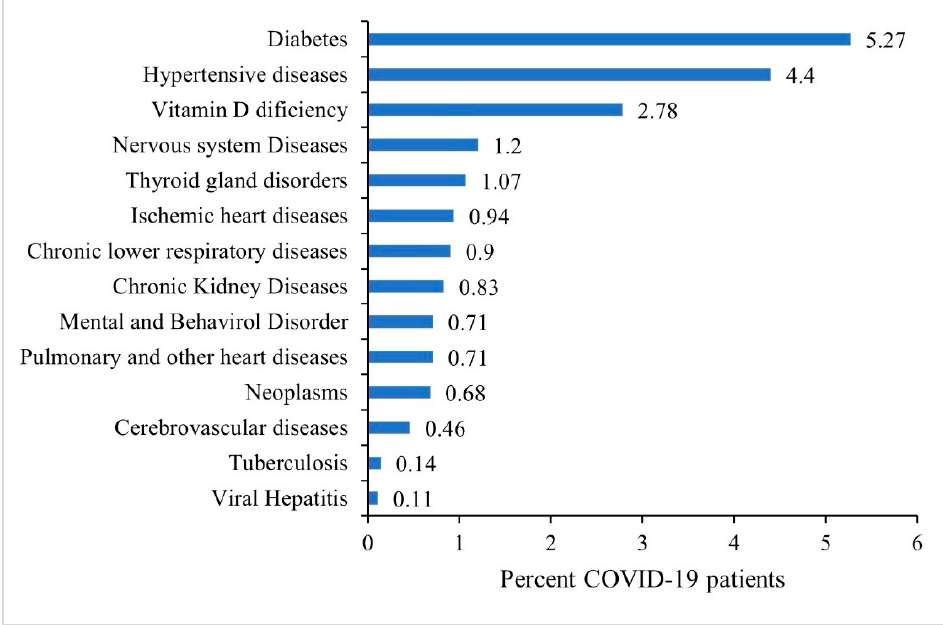
Figure 3. Prevalence of existing co-morbidities among all COVID-19 patients, N = 34,687. A significantly higher percentage of patients who had pulmonary and other heart diseases (27.64%), chronic kidney disease (27.08%), cerebrovascular diseases (25.95%), is- chemic heart diseases (19.57%), and hypertensive disorders (7.87%) were reported as be- ing critical COVID-19 cases (Table 2). There was significant association found between the number of existing co-morbidities and COVID-19 severity with patients reporting multi- ple co-morbidities having worse (critical) severity (11.46%). Table 2. Chi-square test for association between comorbidities and COVID-19 severity, N = 34,687. Mild ≤ 0.001 $Yes